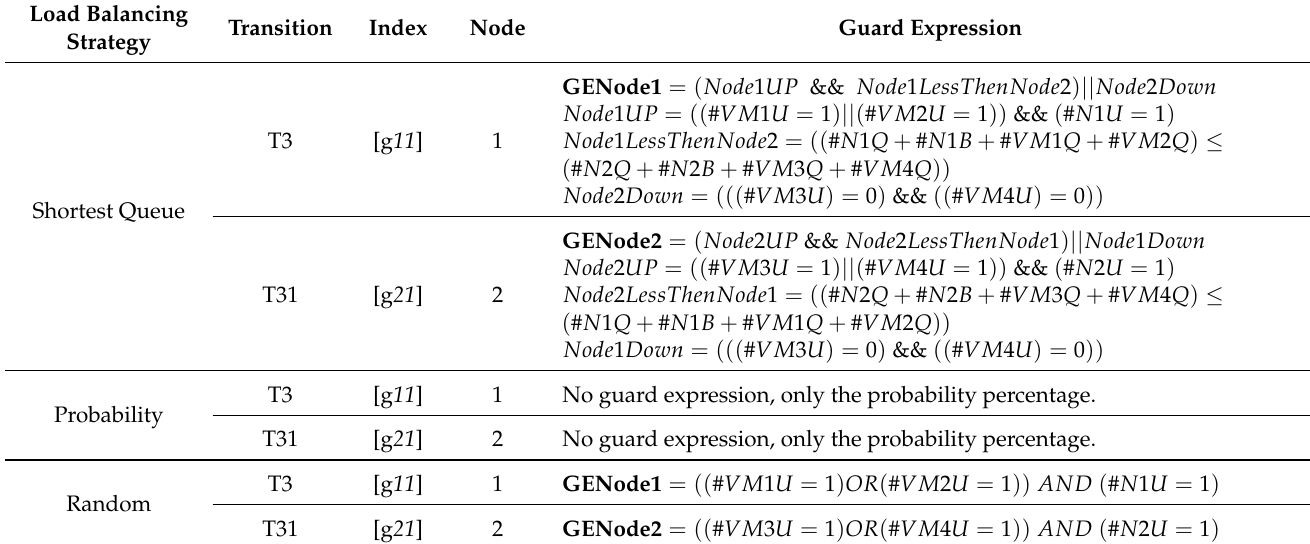
Table 3. Loading Balancing Strategies—Guard Expressions.